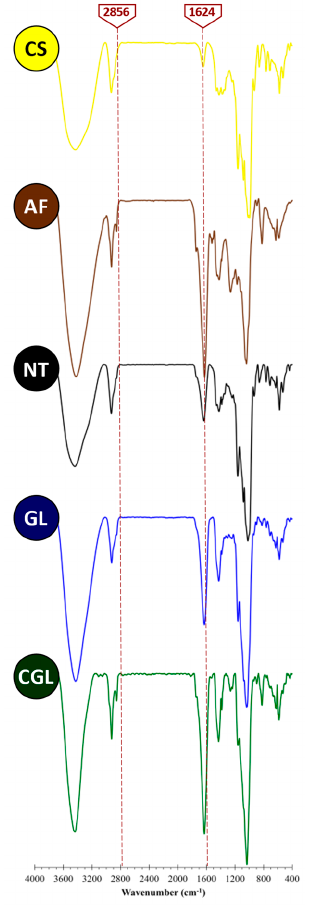
Figure 5. FT-IR spectra of control (CS, and AF, ) and AF–CS (1:1 ratio) samples (NT, , GL, , and CGL, methods). ,